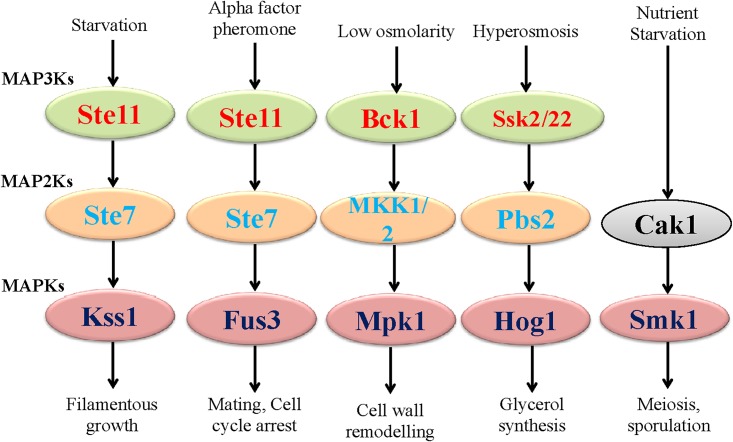
The MAPK cascades in fungi.The Kss1 MAPK that regulates Kss1 pathway is responsible for filamentous growth contains T-E-Y motif in the activation loop domain. The Fus3 MAPK which responsible for mating and cell cycle arrest contains T-E-Y motif in its activation loop domain while Mpk1 which is responsible for cell wall remodeling, contains T-E-Y motif in the activation loop domain. The Hog1 which is responsible for hyperosmosis mediated glycerol synthesis contains T-G-Y motif. The Smk1 which regulates meiosis and sporulation pathway contains T-N-Y motif in the activation loop domain. This suggests that, different signaling pathways mediated by different fungal MAPKs are may be due to presence of different activation loop motifs. The activation loop motif play crucial role in mediating different signaling pathways in fungi.